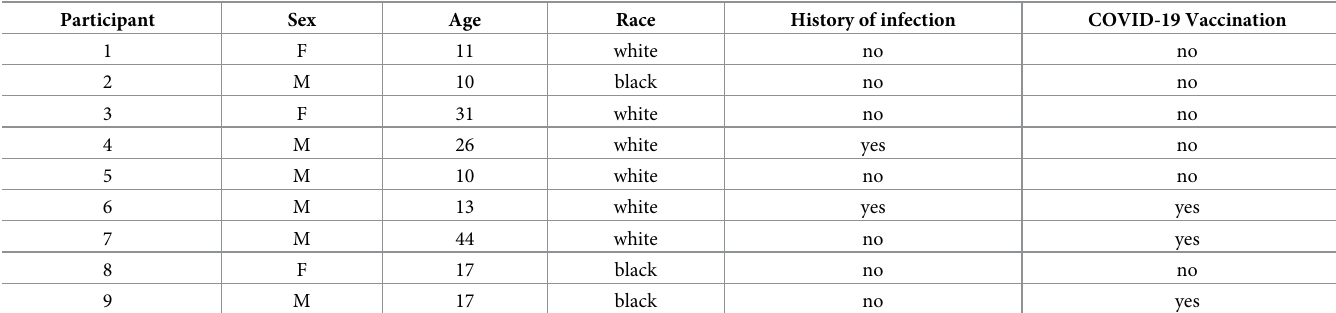
Table 2. Details of the SAR-CoV-2 positive participants.